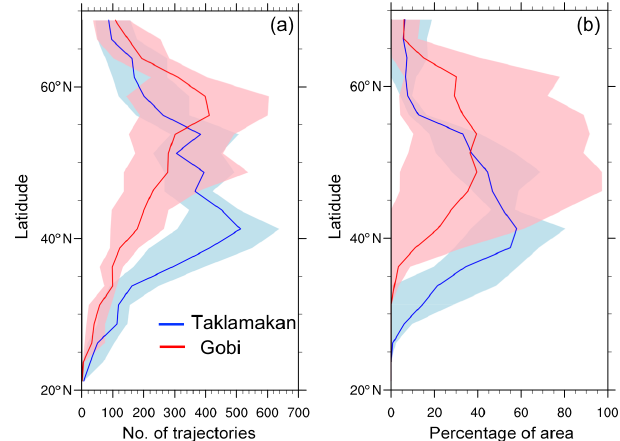
Figure 10. Spread of Taklamakan and Gobi dust to North America by latitude, represented by trajectory passage during 2001–2003. (a) Number of trajectories per year from Taklamakan (blue) and Gobi (red) that pass over each 2.5 ◦ latitude band. (b) Percentage of area in each 2.5 ◦ latitude band influenced by more than 100 trajecto- ries per year from Taklamakan (blue) and Gobi (red). The shadings represent maximum and minimum values among 2001, 2002, and 2003. These years are selected for the analysis because MISR dust plume data are available for both deserts during that